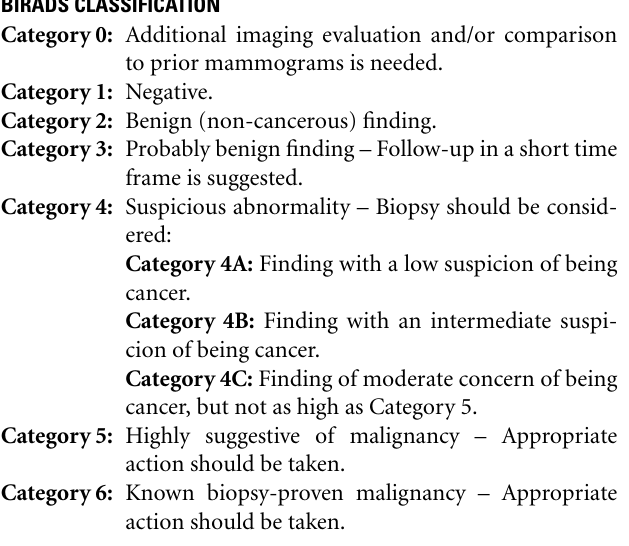
homogenize the diagnosis and injury treatment methods in all